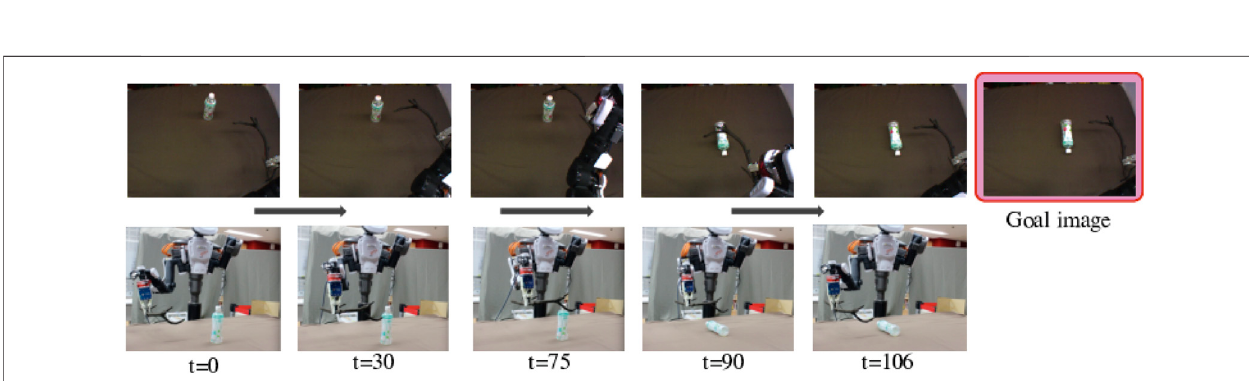
Frontiers in Robotics and AI |